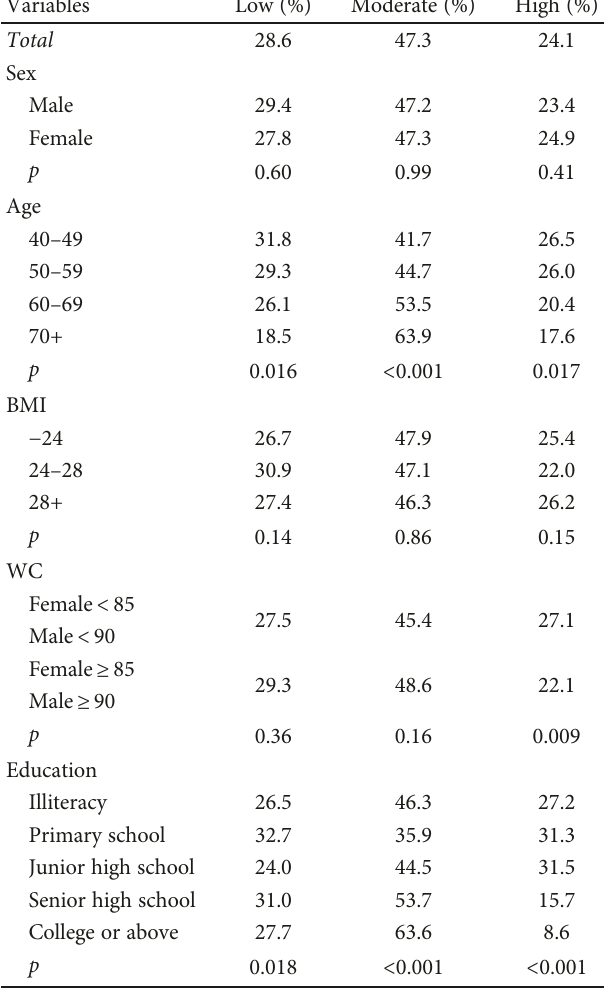
Table 4: The association between social behaviors and physical activity (high level versus the other levels).